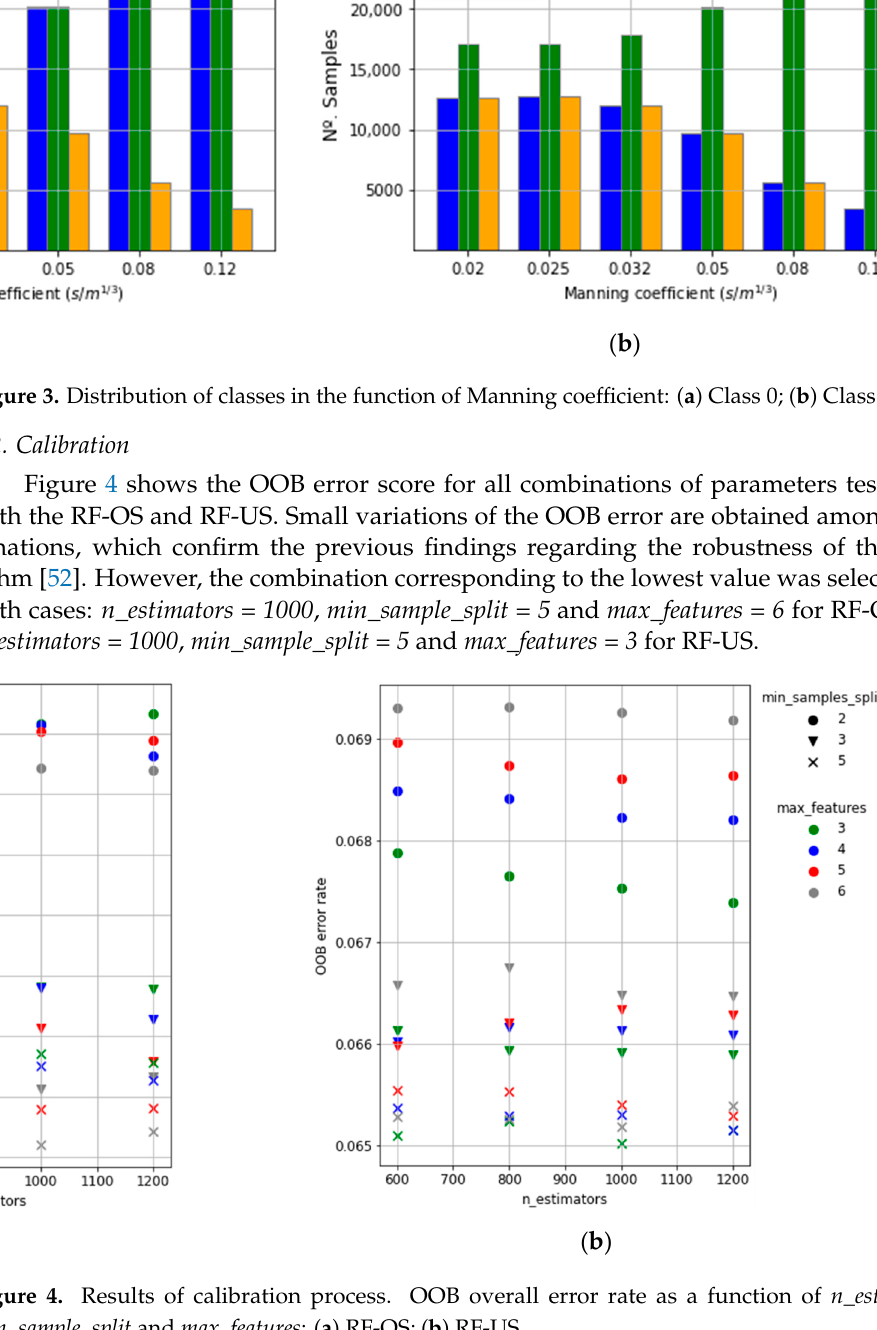
8 of 26 Table 2. Class distribution versus Manning coefficient for the training set. Manning Coefficient (s/m 1/3 )